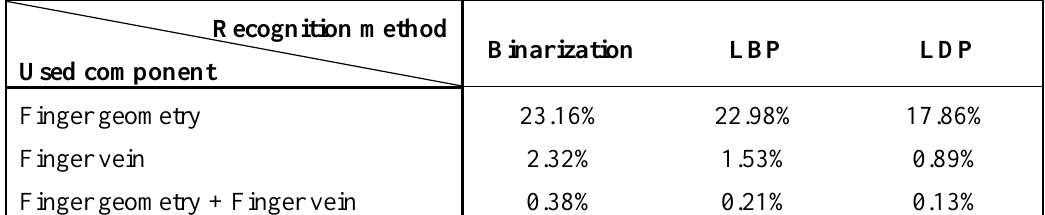
Table 2. EERs according to kinds of component and recognition